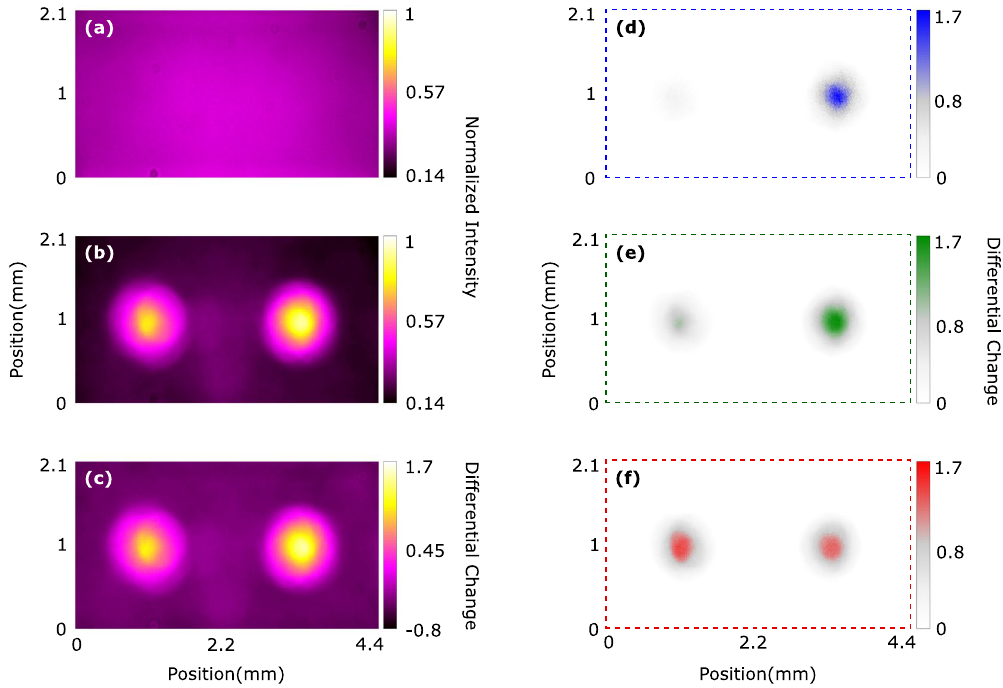
Figure 3. The all-in-one single-channel intensity profile ( a ) before, ( b ) after wavefront shaping. Differential intensity changes for all-in-one single-channel, blue, green, and red channels are shown separately in panels ( c ), ( d ), ( e ), and ( f ),